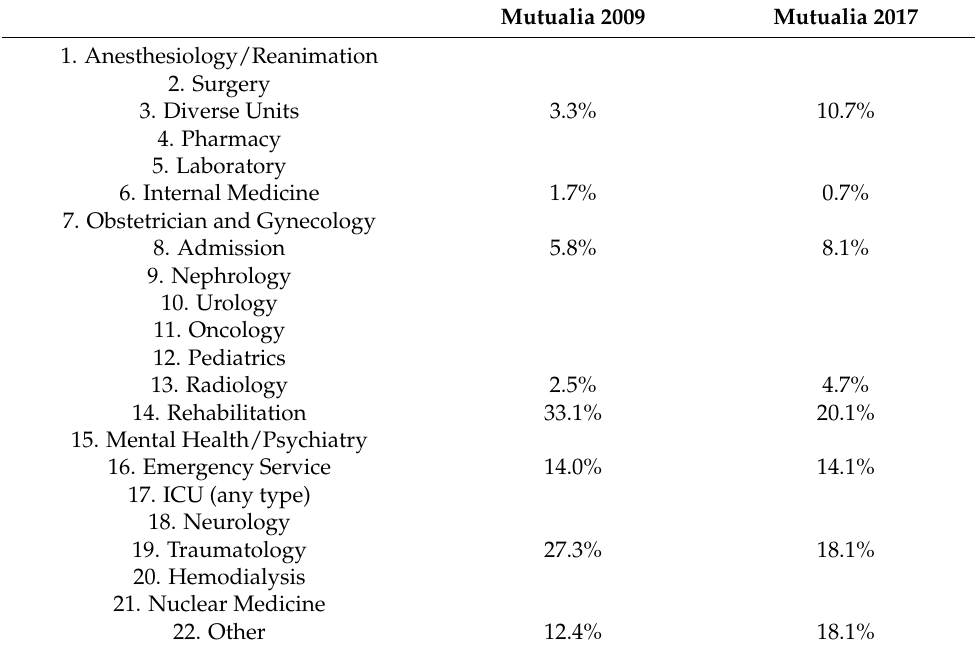
Table 2. Distribution by hospital service (work area) of the personnel who responded to the survey at Mutualia (2009 and